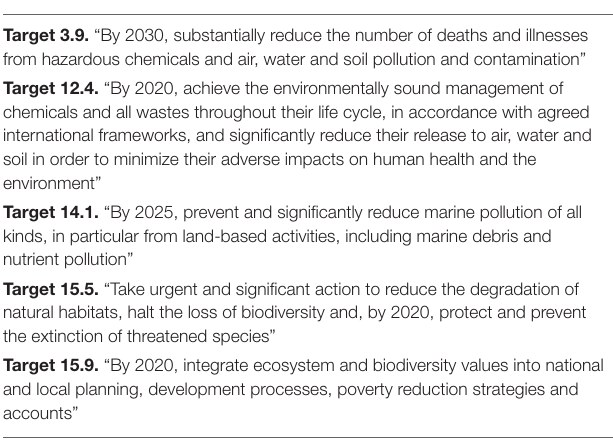
TABLE 2 | Sustainable Development Goal (SDG) targets, endorsed by the United Nations (UN), that may be better achieved through the use of RNAi crop technology, rather than conventional